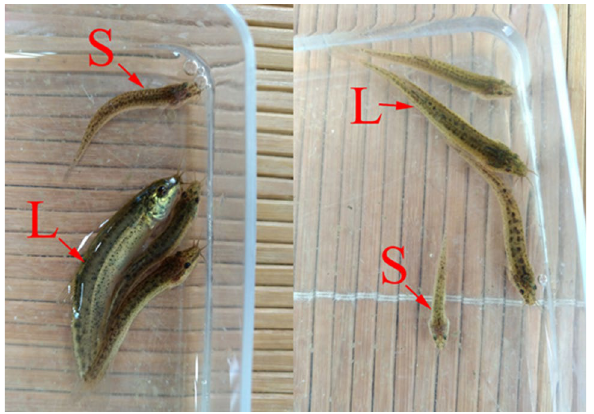
Figure 6. The selection of large-scale loach for LG and SG. Note L selected in LG; S selected in